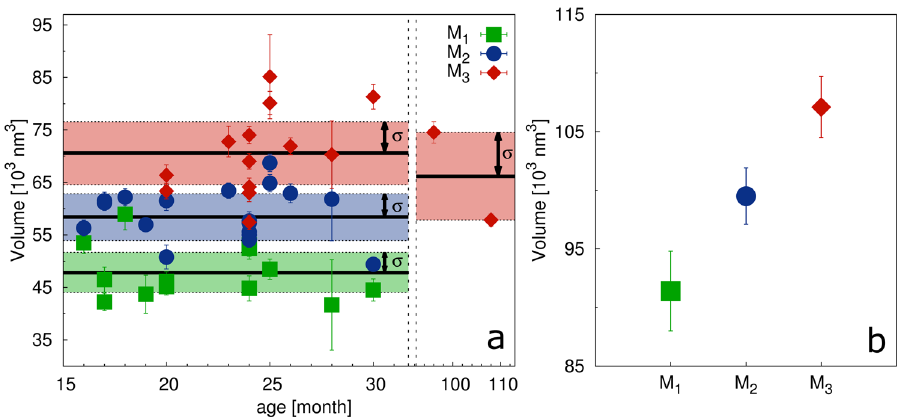
Figure 3. Computed volumes of enamel HAp crystallites of ( a ) miniature pigs. For comparison of changes in crystallite volume with age, the volumes are plotted against the age of each individual. The solid black lines are the average volume for each molar type and the colored areas show a dispersion of data set (1 σ ). Each point in the plot ( b ) represents the average HAp crystallite volume of individual molar types of red